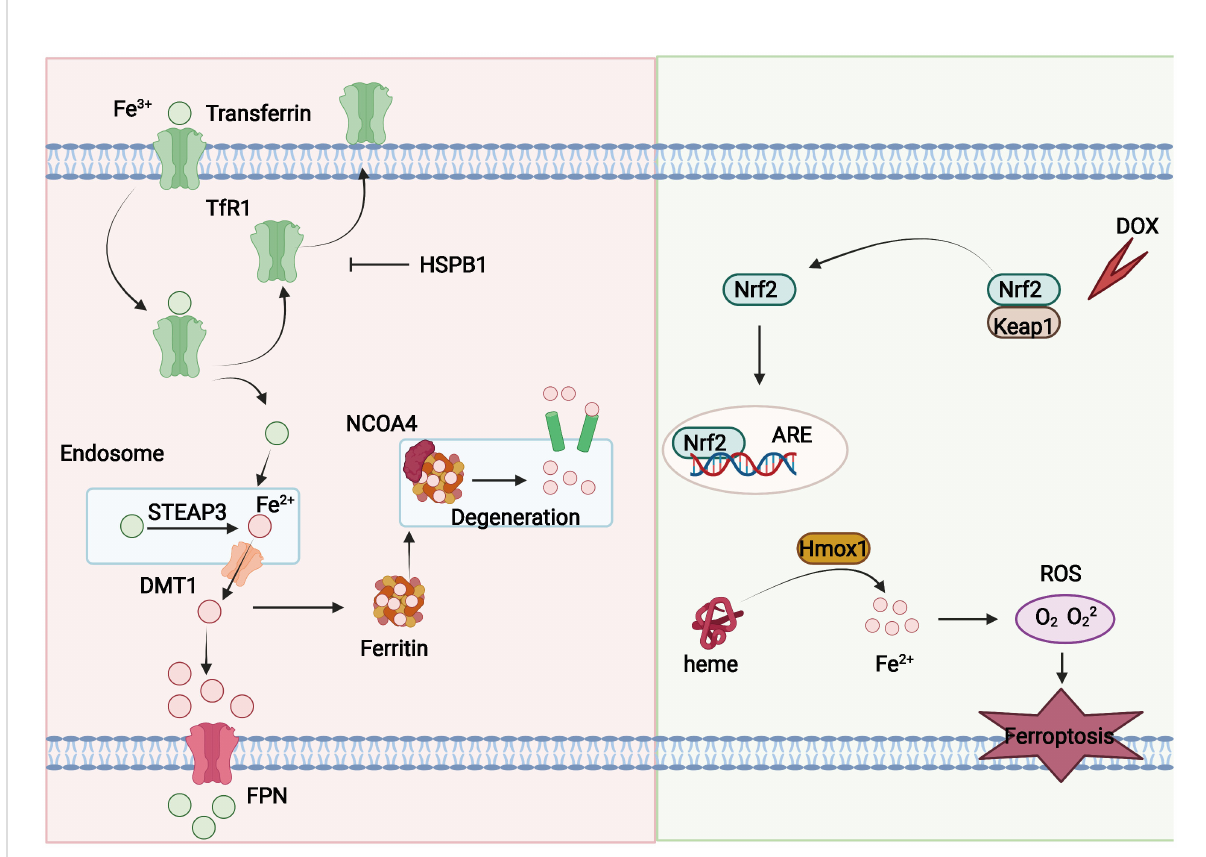
FIGURE 2 Mechanisms of iron metabolism in ferroptosis. Fe 3+ can couple to transferrin and enter the intercellular milieu mediated by TfR1. Transferrin can be recycled and exported extracellularly and blocked by HSPB1. Fe 3+ is reduced to Fe 2+ by DMT1 in endosomes, and Fe 2+ can be transported into the cytoplasm. Fe 2+ can be released from ferritin through NCOA4-mediated ferritin phagocytosis, and part of Fe 2+ can be exported outside the cell and oxidized by FPN. In addition, DOX can also induce ferroptosis. Cardiac output of DOX activates the Keap1/Nrf2 pathway, and Nrf2 further activates the downstream protein Hmox1 and prompts it to oxidize heme and release iron, leading to